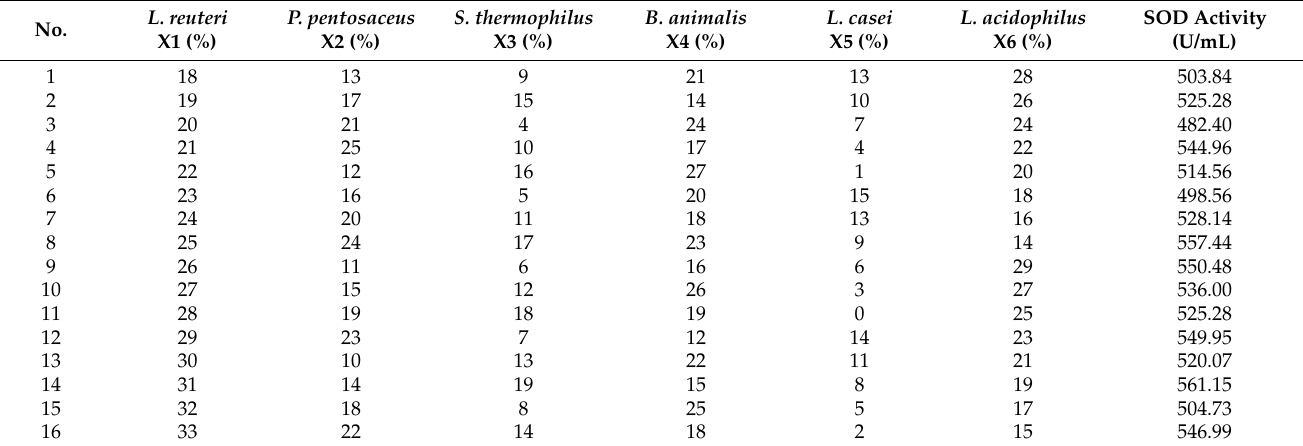
Table 4. Results of uniform design experiments.